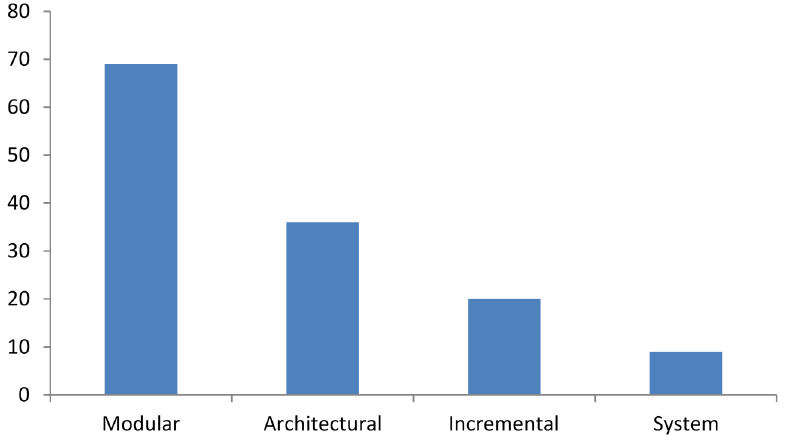
Figure 6. Innovation novelty categories that focused on either sustainability, safety or